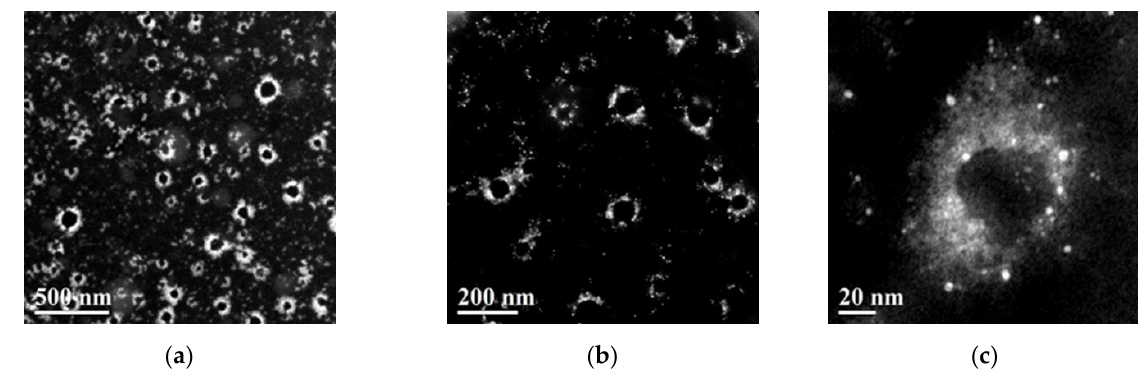
Figure 8. HAADF-STEM images of the MOLNBs decorated with SPIONs taken at different magnifications ( a = 500 nm, b = 200 nm, c = 20 nm).